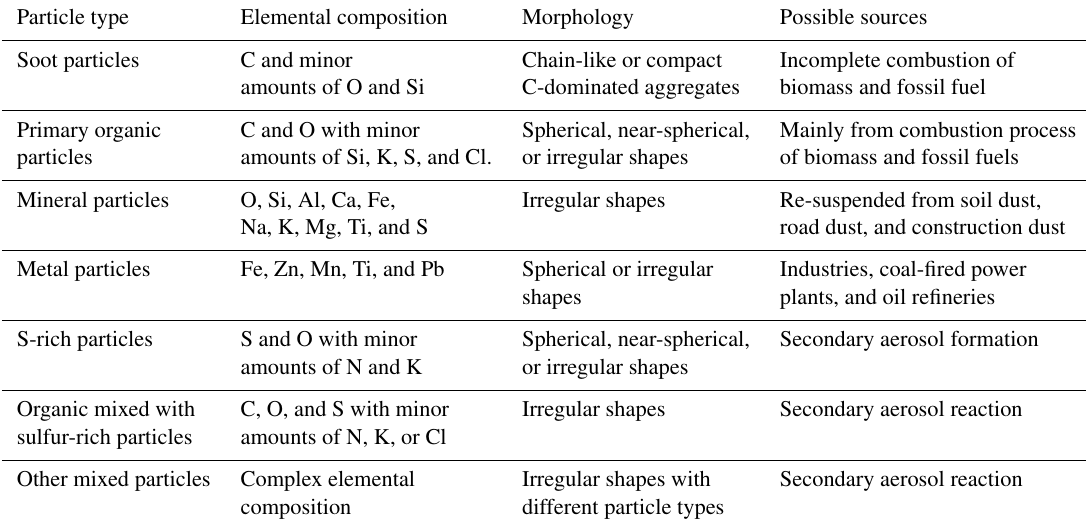
Table 2. Classification and characteristics of individual particle